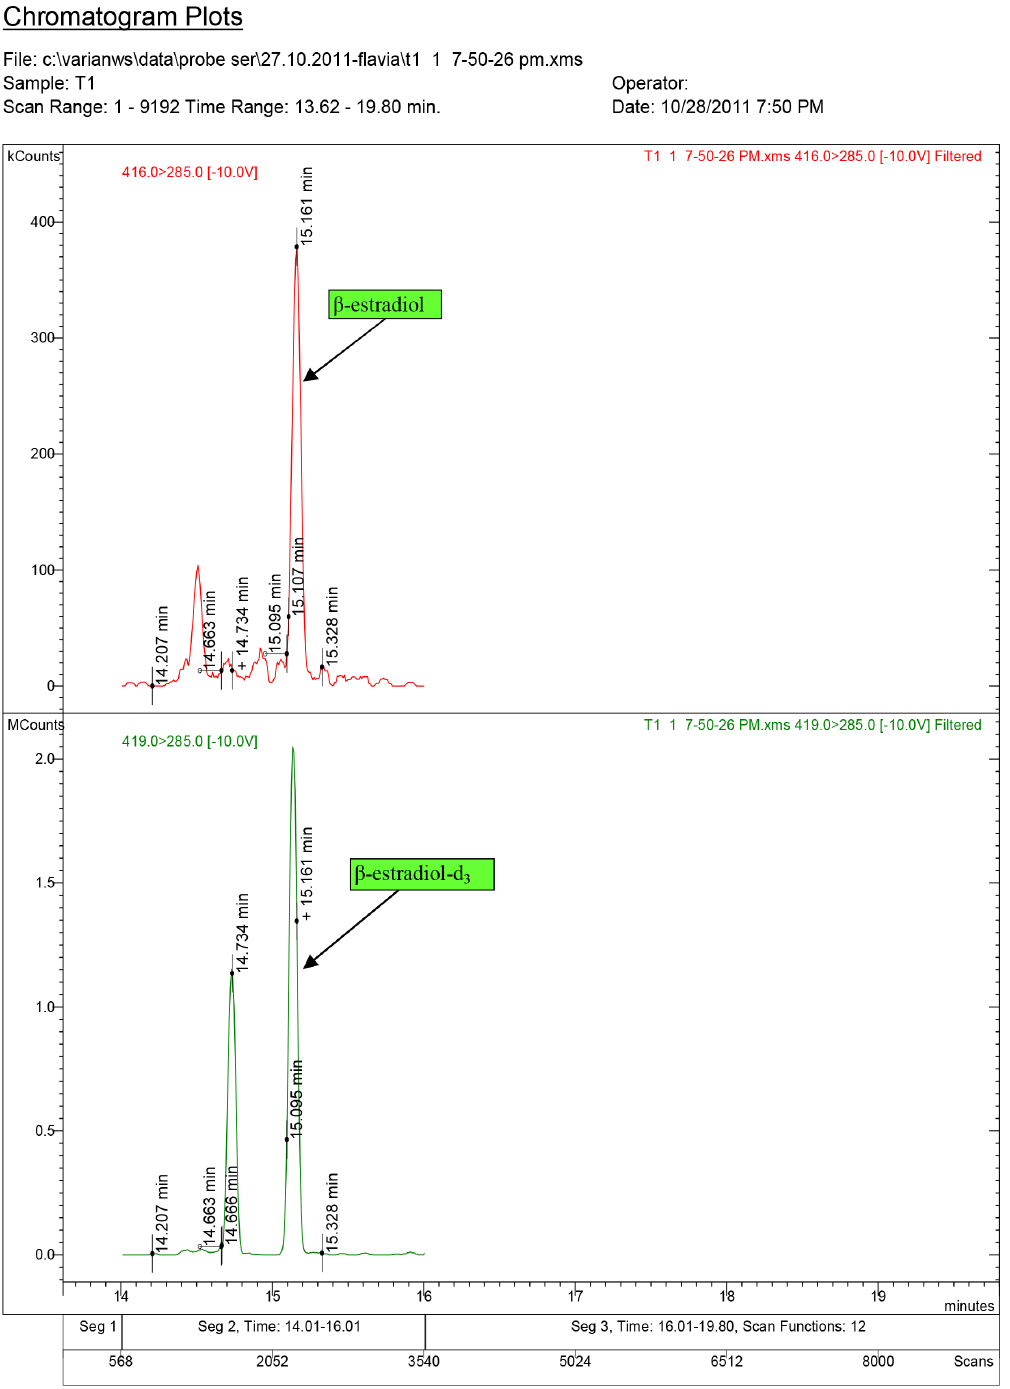
Figure 8. Diagnostic ions for serum sample T1, where 17 b -estradiol was quantified at 0.11 ng/ml (group T1., dose: 1.5 mg/kg.bw).